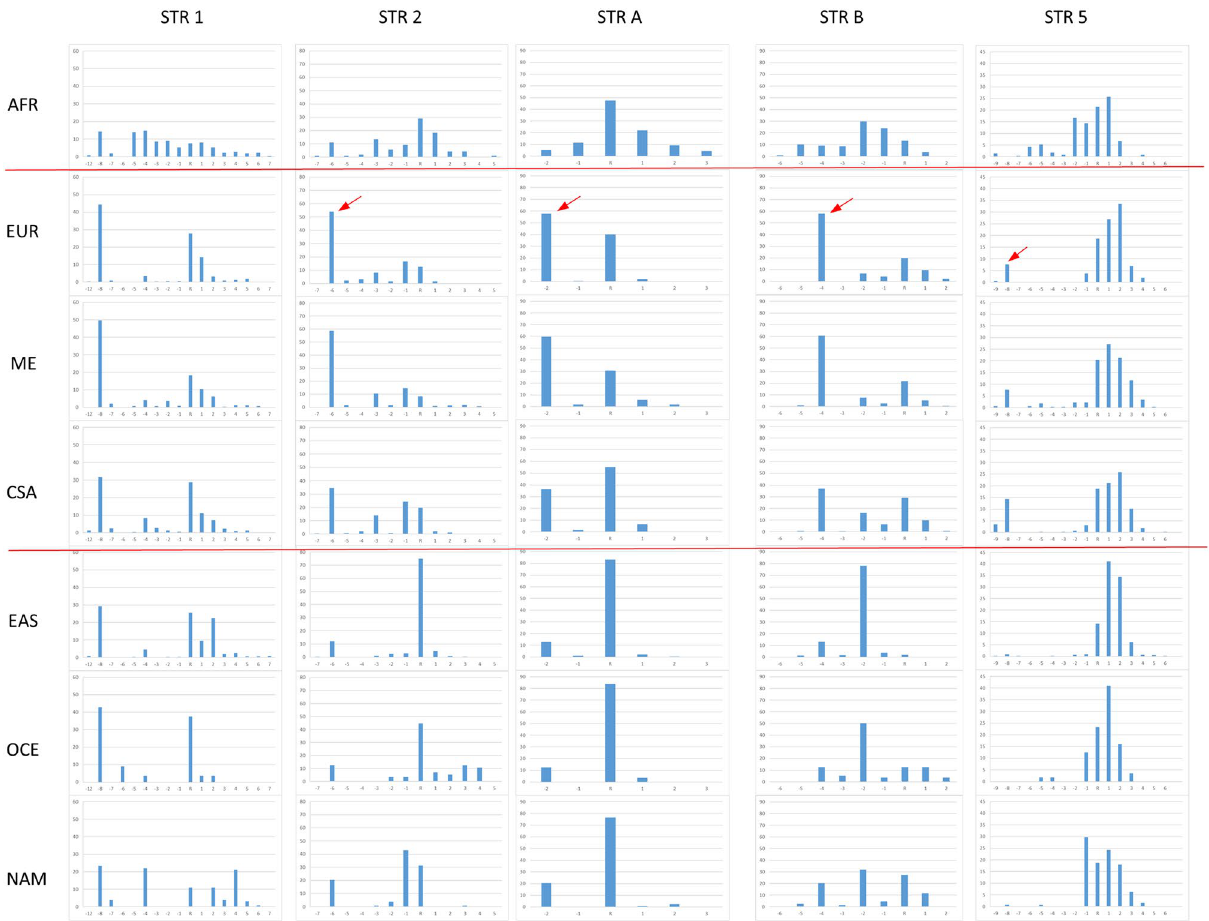
Figure 2. Allele frequency distributions of nine STR markers estimated for the major HGDP-CEPH population groups of Africa (AFR n = 105), Europe (EUR n = 158), Middle East (ME n = 162), Central-South Asia (CSA n = 202), East Asian (EAS n = 230), Oceania (OCE n = 28) and Native America (NAM n = 64). Each bar indicates the frequency value of the allele named in the x-axis. Low polymorphic STR 3 and 4 are not reported. Red arrows indicate alleles highly frequent (about 50–60%) or private to Eurasia and low frequent (about 10%) outside this geographic region. Two horizontal lines separate Eurasian populations from the